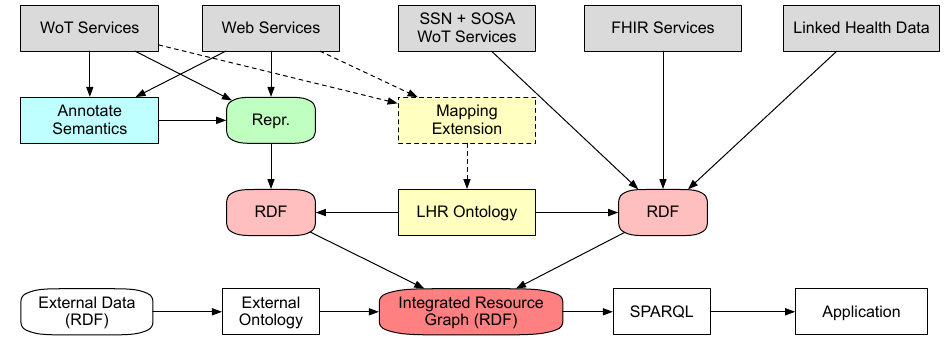
Figure 4. A data-centric view of the integration